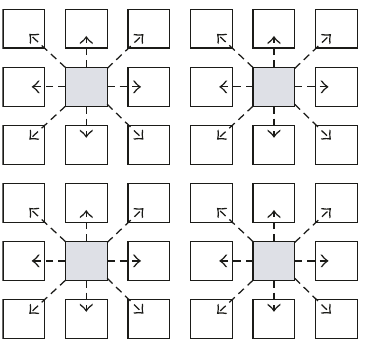
Figure 22: Semiglobal control with one controller per group of